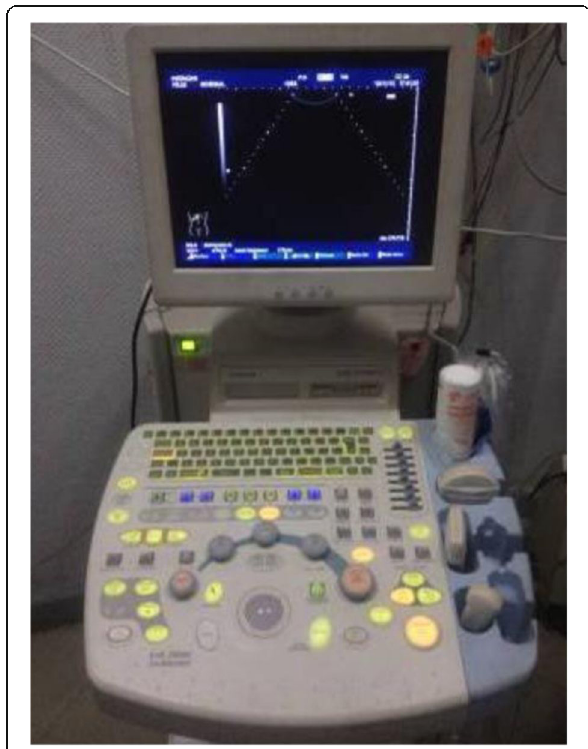
Fig. 1 Photographic plate of Hitachi 5500 Transthoracic US machine.